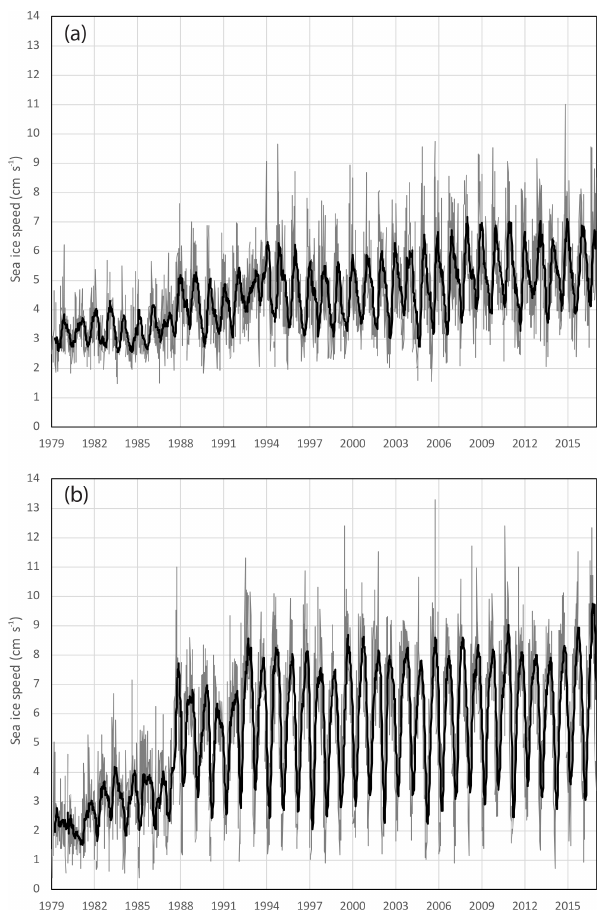
Figure 8. Arctic weekly average sea ice drift speed for Version 4, 1979–2017. A 13-week running average is overlaid on the weekly values to highlight seasonal variability.